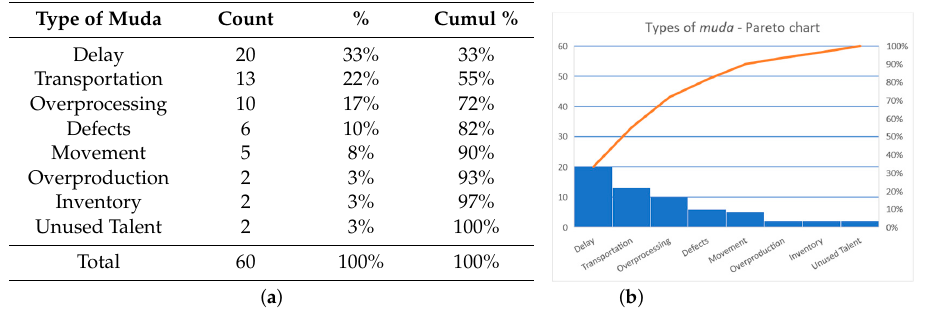
Table 4. Summary of the di ff erent types of Muda: ( a ) Data, ( b ) Pareto chart.